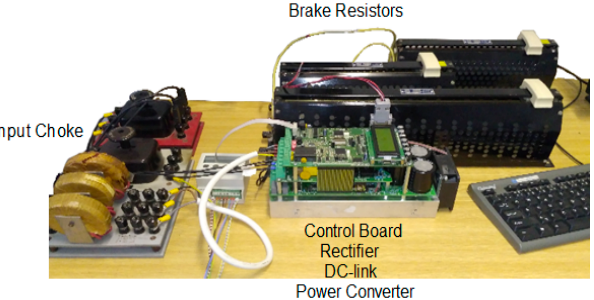
Figure 15. The experimental setup with VQFREM 400 004–4MA converter.